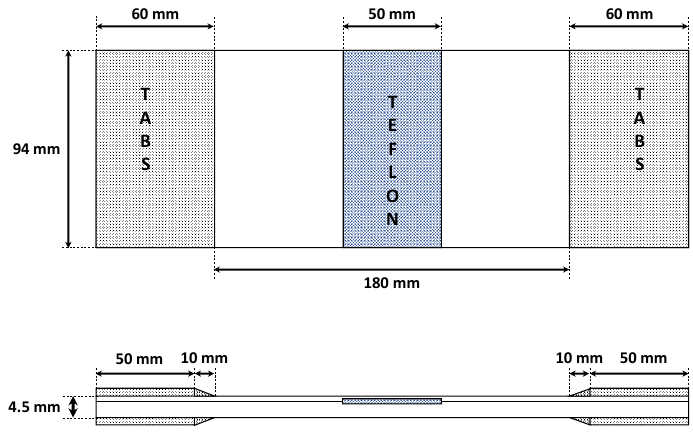
Figure 1. Geometrical description of the specimens.